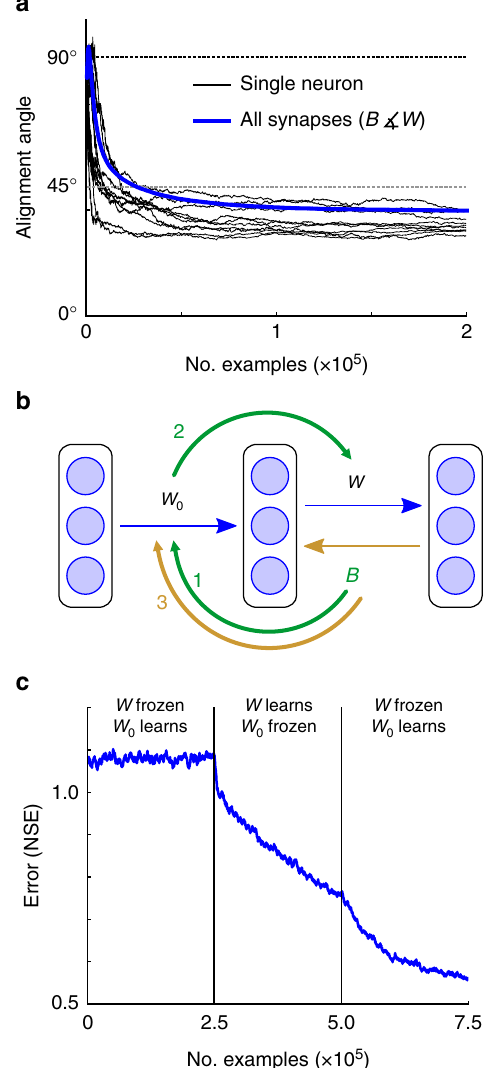
Figure 5 | Mechanics of feedback alignment. ( a ) W aligns with B T (blue line), and single hidden neurons (black lines) exhibit the same alignment of their forward and feedback weights. ( b ) Schematic showing the information flow in feedback alignment. Synaptic weight information from B flows back into W 0 (1) and then forward into W (2). As W aligns with B T , B begins to act like W T , sending useful teaching signals to the hidden units (3). ( c ) To reveal this flow of information, we can artificially break the learning into three phases. In the first phase W is frozen while W 0 learns; this learning does not reduce the error because changes are driven by a feedback matrix B that is not aligned with W T . In the second phase W 0 is frozen while W learns. In the third phase W is again frozen while W 0 learns, but now learning does reduce the error, because W aligned with B T during phase